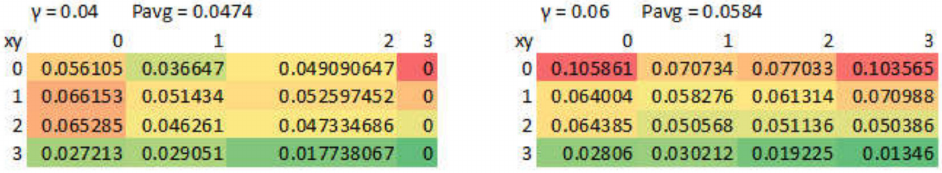
Figure 4. Deflection frequencies heat map for 4 × 4 × 1 NoC with uniform random traffic and injection rates 0.04 and 0.06 flits/cycle/node. The average deflection probability is close to the injection rate for injection rates up to 0.12 flits/cycle/node for this